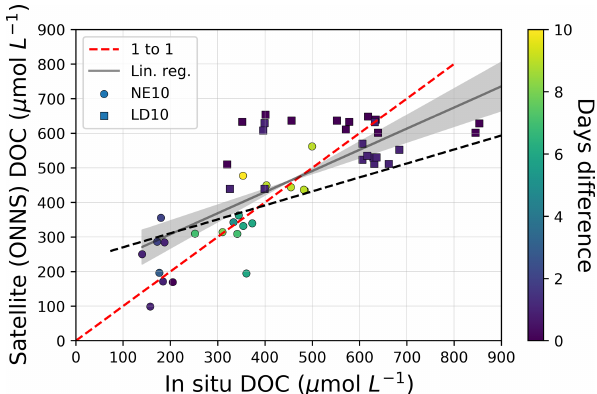
Figure 8. Comparison of in situ DOC and ONNS-derived DOC. The dark grey line shows a linear regression ( r 2 = 0 . 53, slope of 0.61, n = 50). The grey area represents the 95% confidence in- terval. The red line indicates 1 : 1 correspondence. Day difference (symbol colour) shows the temporal offset between the satellite scene and in situ water sampling. The dashed black line shows the satellite DOC concentration calculated by using the DOC– a CDOM (443) relationship from Matsuoka et al.